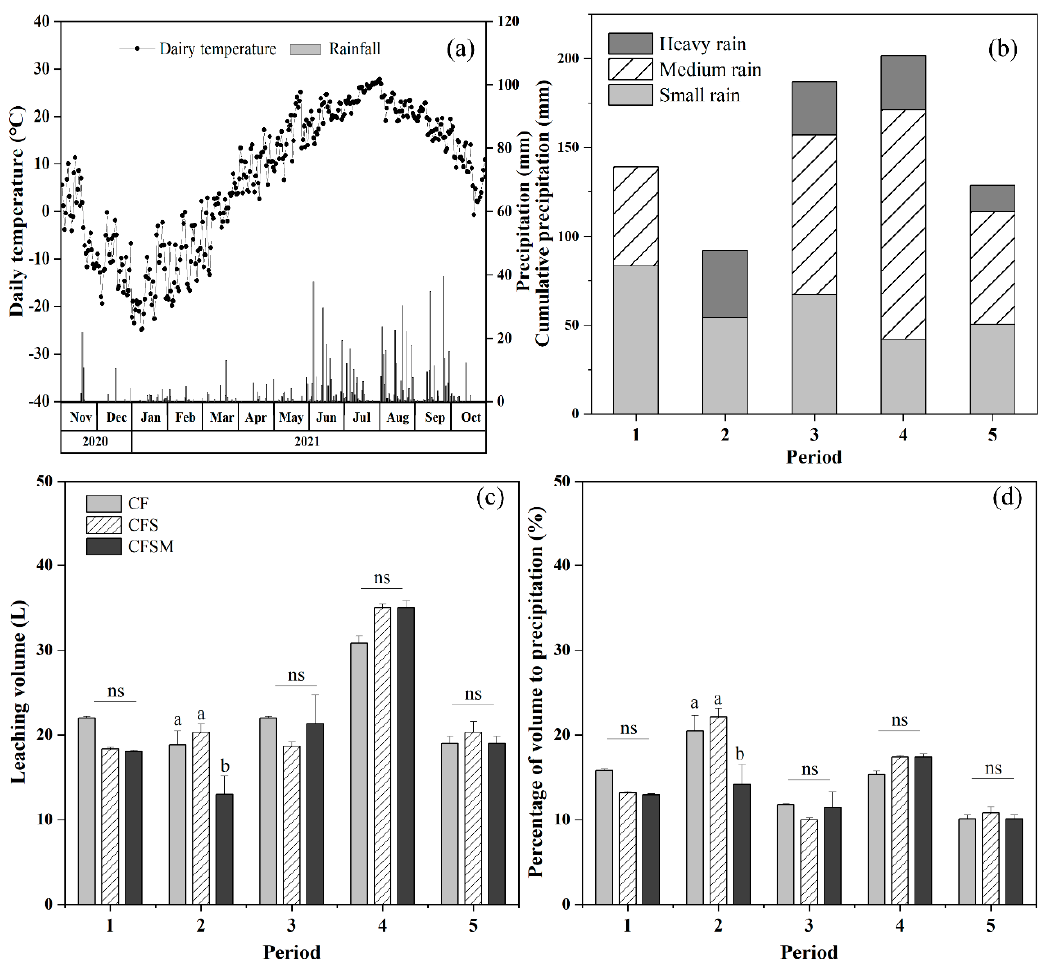
Figure 2. Seasonal variations in soil surface temperature and precipitation ( a ), cumulative precipitation ( b ), cumulative leachate volume ( c ), and percentage of precipitation lost through leaching ( d ) during different periods of a growing season. Periods from 1 to 5 represent the period from 10th January to 27th April, from 28th April to 8th June, from 9th June to 27th July, from 28th July to 24th August, and from 25th August to 31st August, respectively. October. Small, medium, and heavy rain represent volumes of daily rainfall of less than 10 mm, 10–25 mm, and over 25 mm in 24 h. Different lowercase letters on each sample date indicate significant differences among different treatments at p = 0.05, and ns mean no differences among the treatments.